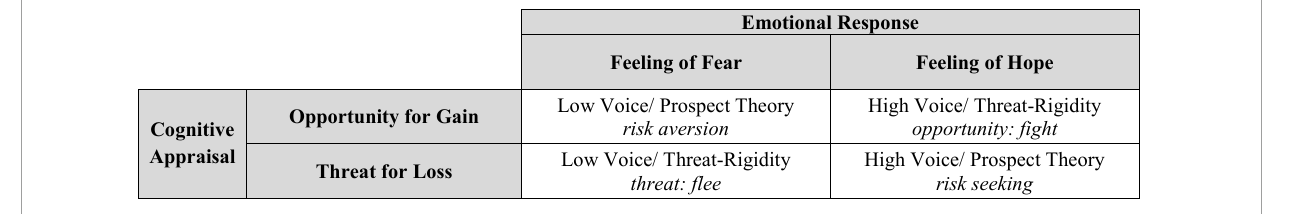
FIGURE1 Cognitive and emotional response to stressors.